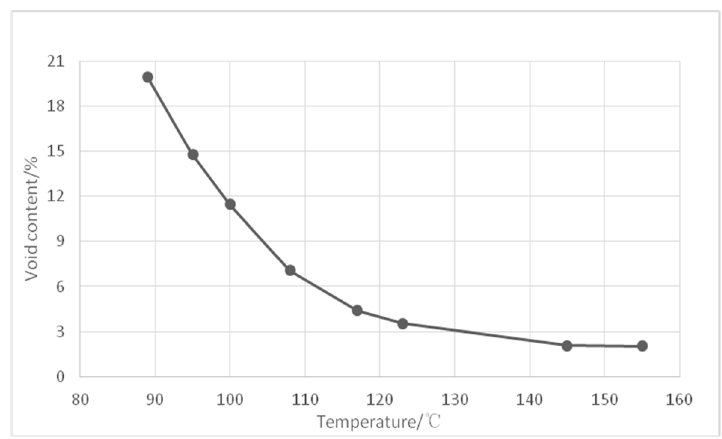
Figure 2. Relation between the voids content and preparation temperature.